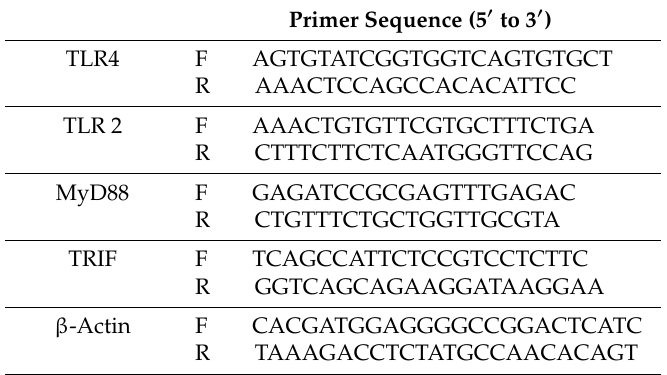
Table 1. Primers sequence used for real-time